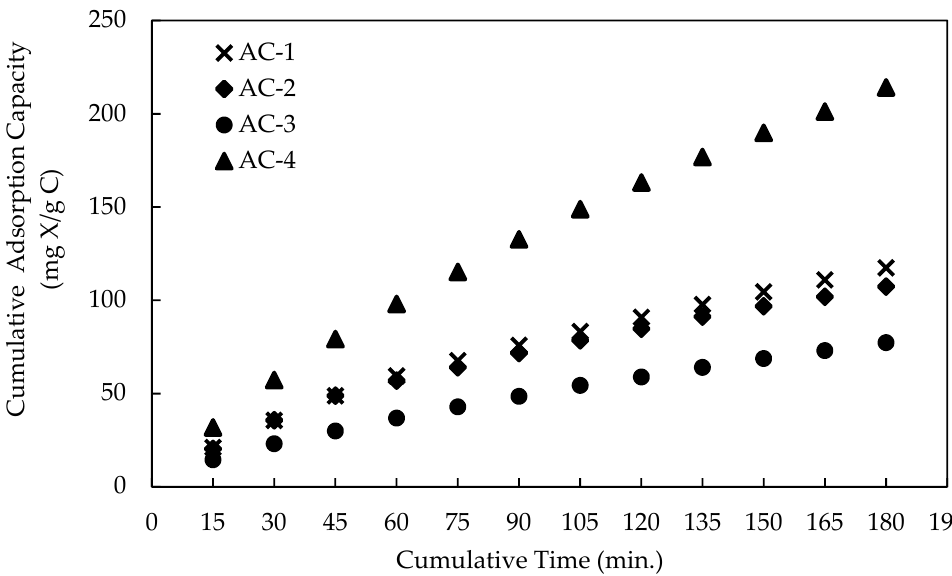
Figure 2. The amount of xanthate adsorbed by the reused activated carbon samples; agitation speed, 200 rpm; 50 mL xanthate solution (1590 mg/L); the amount of activated carbon, 2 g.